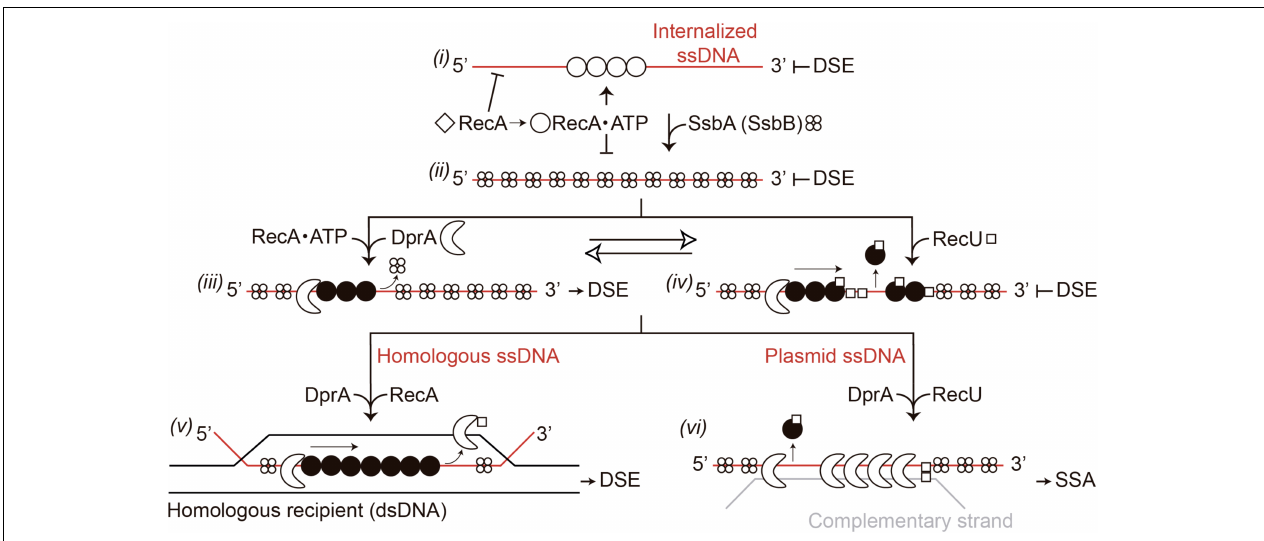
FIGURE 9 | Model for RecA filament assembly on DprA-ssDNA-SsbA complexes in the presence of RecU. Apo RecA (empty diamonds) does not nucleate onto the internalized ssDNA. When ATP is present, RecA undergoes its first structural transition (empty circle). RecA-ATP can bind to incoming ssDNA and hydrolyze ATP, but cannot catalyze DNA strand exchange (DSE) (step i ). When SsbA is present, RecA · ATP cannot nucleate on the SsbA-ssDNA complexes and cannot catalyze DNA strand exchange (step ii ). Following interaction with DprA, SsbA recruits it onto the ssDNA. DprA in the DprA-ssDNA-SsbA complex interacts with and recruits RecA · ATP, to establish the 5 (cid:48) -end of the RecA filament. RecA undergoes its second structural transition (filled circle); and this active RecA assembles onto SsbA-coated ssDNA. Activated RecA remodels the SsbA-ssDNA complex to generate a DNA structure competent for SsbA displacement and RecA catalyzes DNA strand exchange in the presence of DprA-SsbA (step iii ). RecU blocks RecA assembly on the ssDNA and promotes disassembly from the ssDNA (step iv ). In the presence of homology with the recipient strand and a limiting concentration of DprA, it assists RecA · ATP assembly by displacing RecU to favor chromosomal transformation (step v ). In the presence of plasmid ssDNA, DprA binds to plasmid ssDNA and, upon interaction with DprA-bound to a complementary incoming plasmid ssDNA (gray line), assists in the disassembly of RecA and RecU, and catalyzes single strand annealing (SSA) (step vi ).